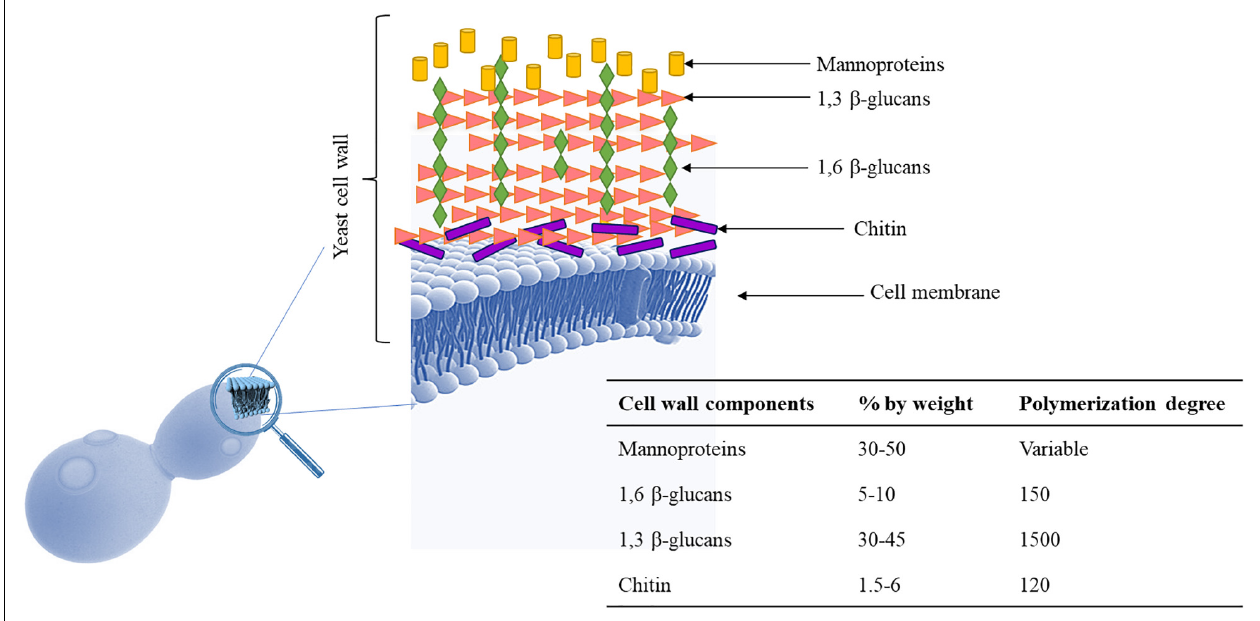
FIGURE 1 | Yeast cell wall. It is made up of mannoproteins, β -1,3-glucans, β -1,6-glucans, and chitin. Cell wall may undergo several changes during alcoholic fermentation because they are exposed to several stresses (osmotic stress, low pH, high acidity, nitrogen depletion, elevated ethanol) which should increase anthocyanins adsorption. Macromolecules of S. cerevisiae cell wall (Klis et al., 2006; De Iseppi et al.,